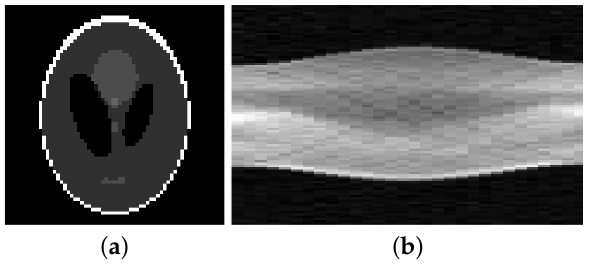
Figure 14. The Shepp-Logan phantom image of size 64 × 64 pixels and its measured sinogram.